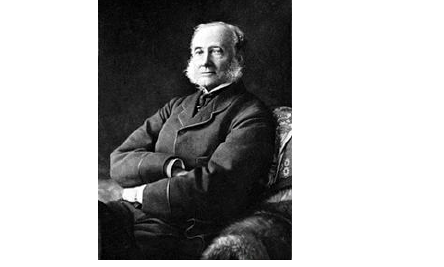
Figure 3 . Alcock (Rutherford Alcock, 1807 ~ 1897) (Source: The Michie of The Englishman in China During A. The Victorian Era: of As in The Illustrated Career of Sir Rutherford